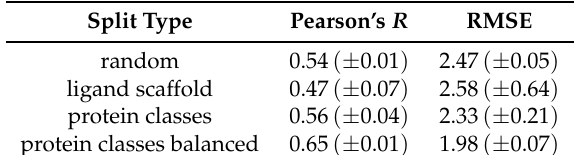
1std.) for the four different proposed split types in ±